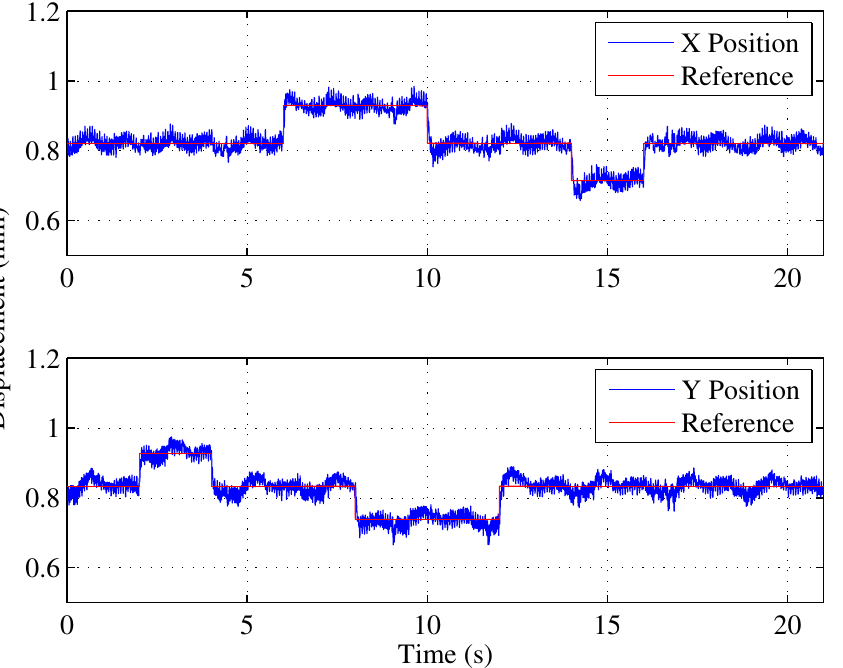
Figure 13. Position controllers’ output for step input references changes—a three-phase system with a radial